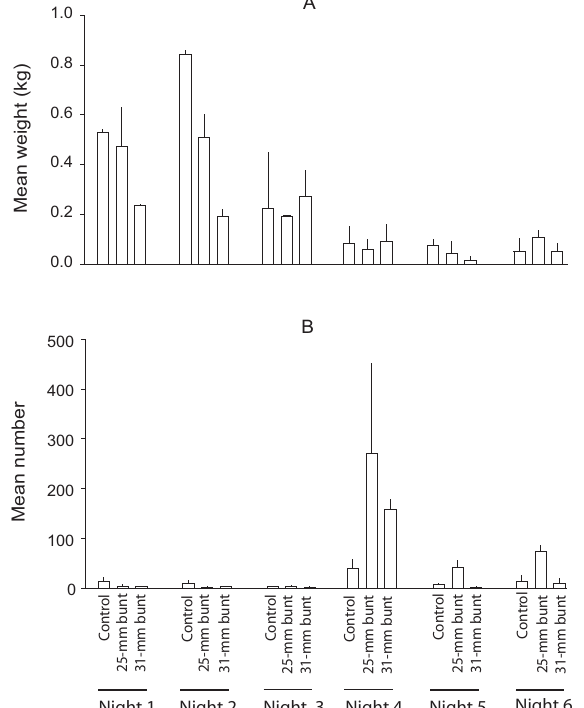
F IG . 7. – Differences in mean catch (+ SE) between the control and 25 and 31 mm bunts and nights in experiment 2 for A) weight of greasyback prawns and B) number of southern